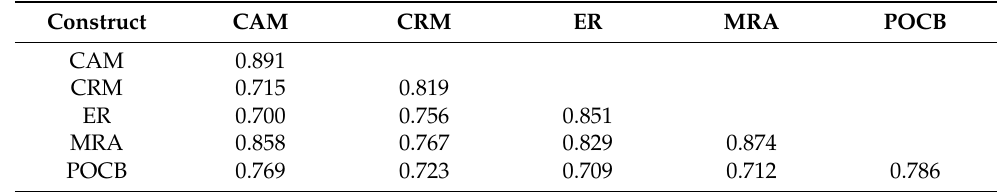
Table 4. Discriminant validity Through Fornell-Larcker criterion.